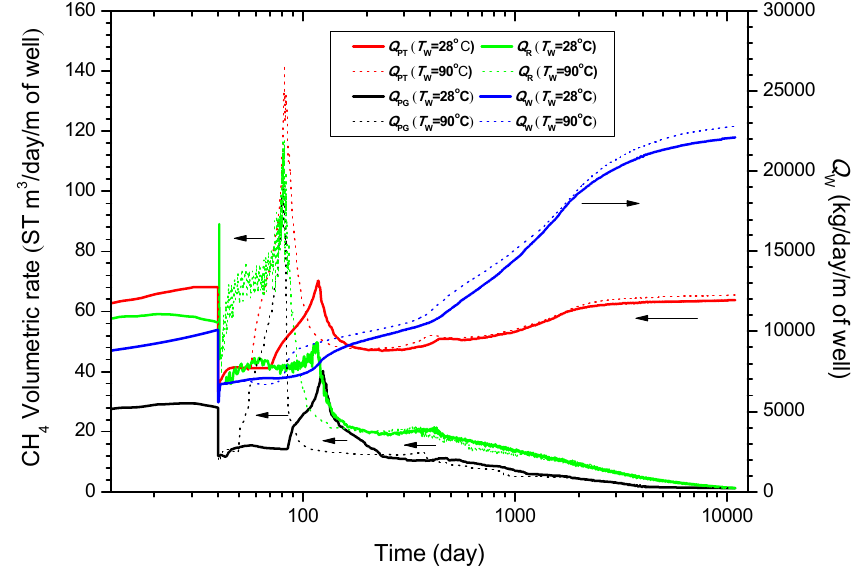
Figure 11. Evolution of Q injected brine during hydrate